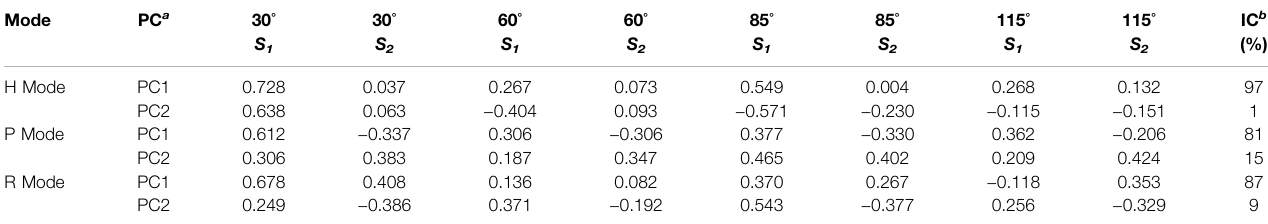
TABLE 2 | Principal component coef fi cients and interpretation coef fi cients under different mode for pollen and non-biological samples MAPIS data.